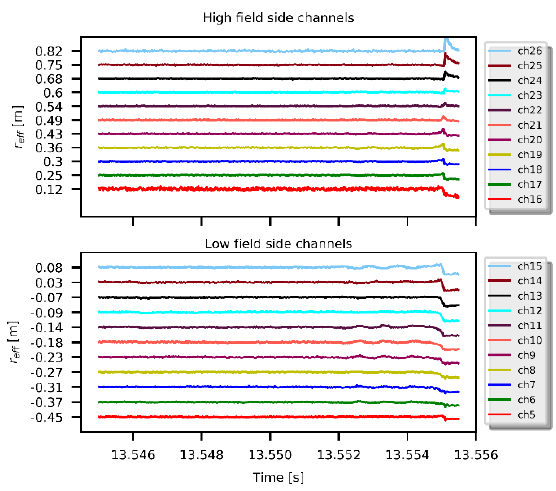
Figure 8 : Time traces zoom on ending part of the discharge. ECE signal are normalised with respect to their average value. LFS channels display temperature decrease, HFS channels display a temperature increase. . ECE cold resonance radii are represented on the